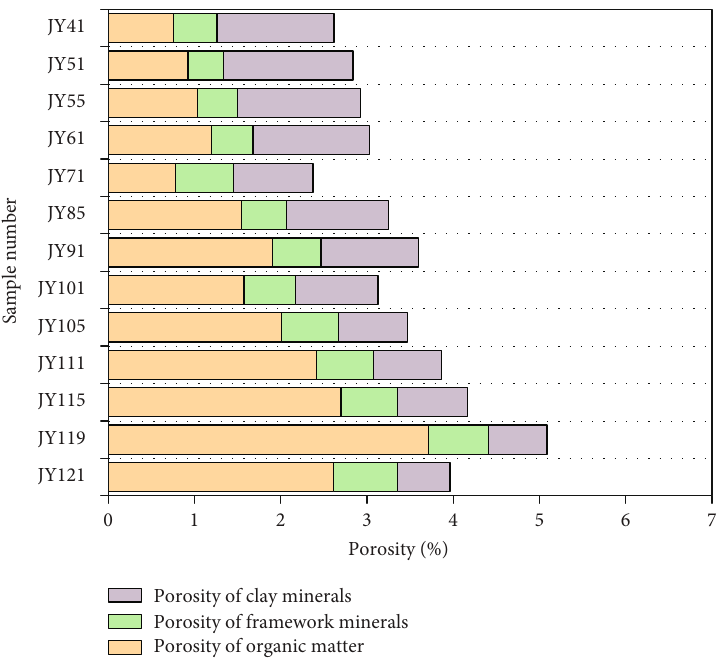
Figure 10: The calculated porosity of organic matter, framework minerals, and clay minerals of the studied shales.